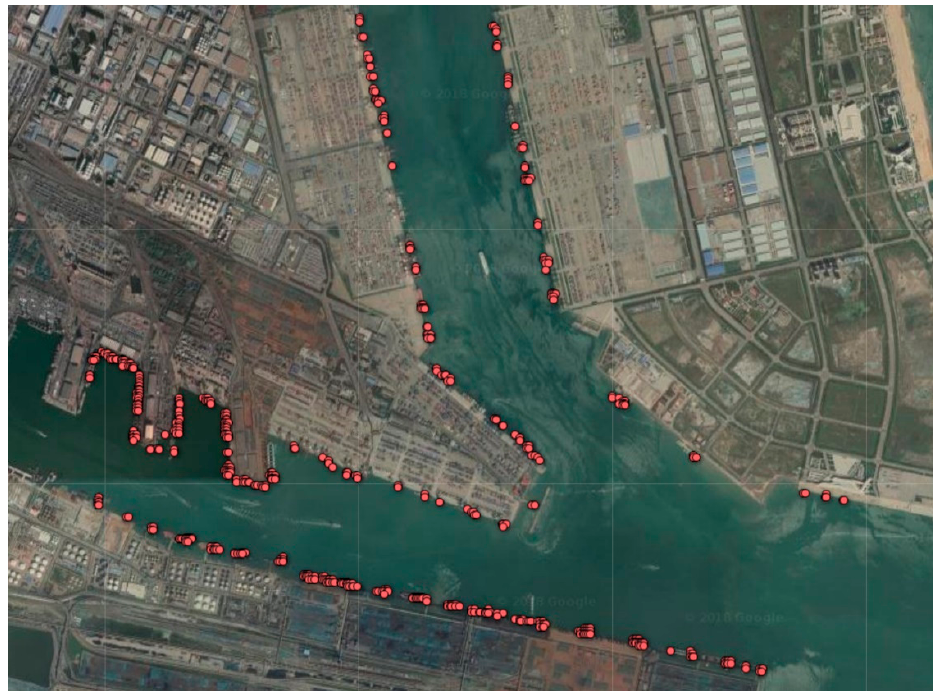
Figure 8. Berth grid cells/OD events detected in the busiest part of the Tianjin Port. These cells also correspond to positions of historical port call events.